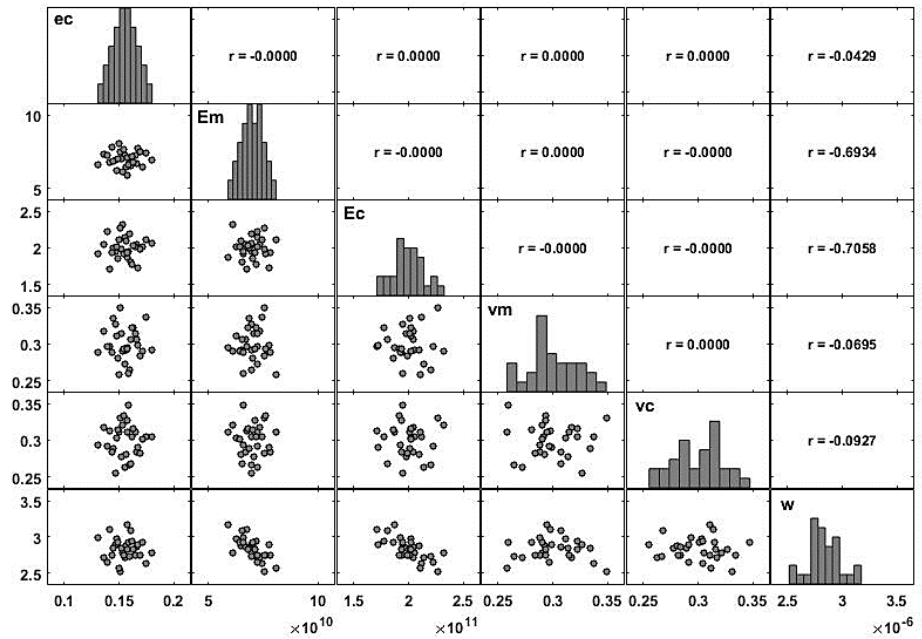
Figure 5. Matrix plot of the modeling parameters (inputs and output): case 3.2.1 — Thicker core.